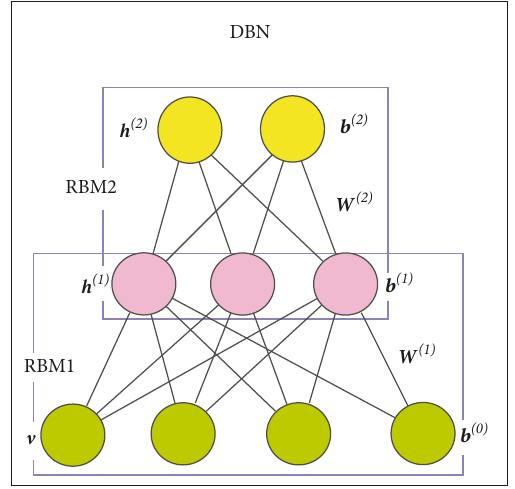
Figure 2: A 2-layer deep belief network that is stacked by two RBMs contains a lay of visible units and two layers of hidden units. Where ℎ (1) and ℎ (2) are the state vectors of the hidden layers, 𝑣 is the state vector of the visible layer, 𝑊 (1) and 𝑊 (2) are the matrices of symmetrical weights, 𝑏 (1) and 𝑏 (2) are the bias vector of the hidden layers, and 𝑏 (0) is the bias vector of the visible